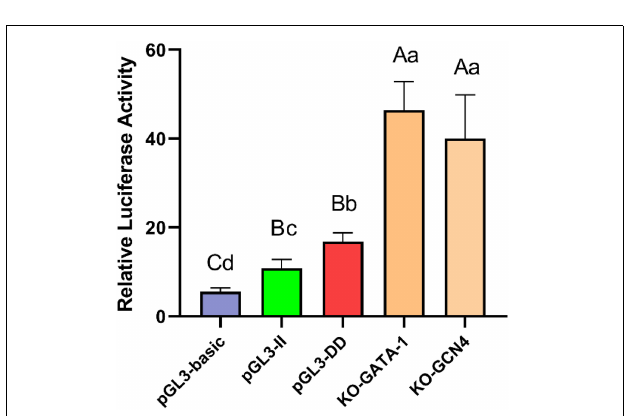
FIGURE 9 | Luciferase activity in DF-1 cells transfected with recombinant plasmids. Data are presented as the means ± SD ( n = 6 samples of each plasmid). Columns with different letters (A,B) indicate P < 0.01, columns with different letters (a,b) indicate P < 0.05, and columns with the same letter indicate P >